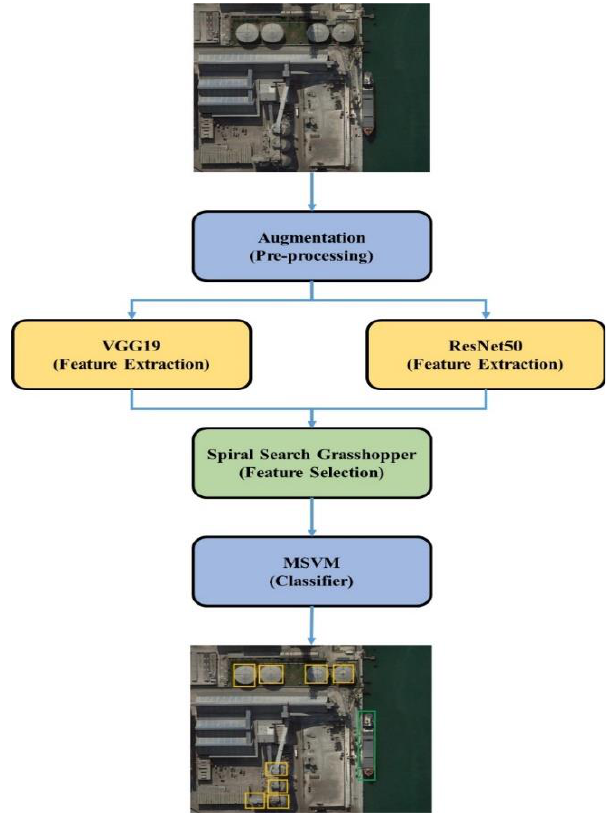
Figure 1. The SSG model in remote sensing object detection.